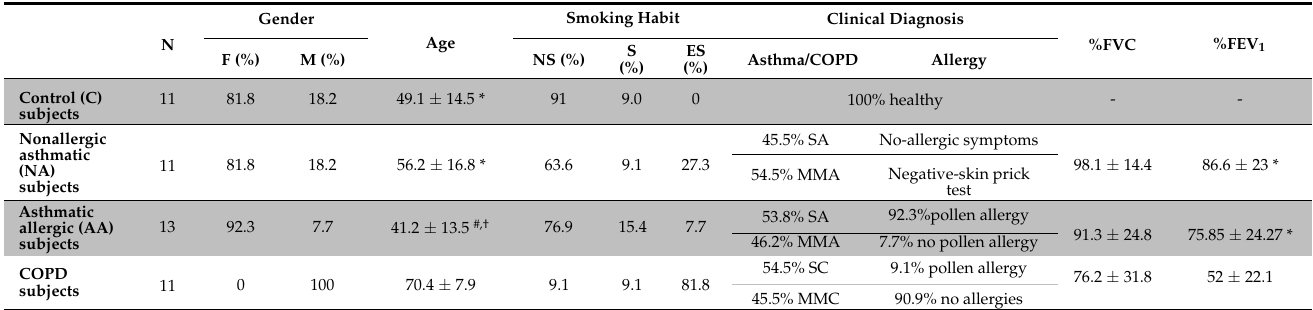
Table 1. Demographic and clinical characteristics of the study